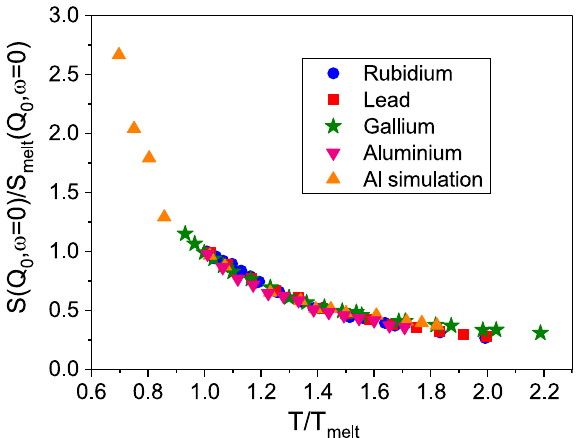
Figure 5. Amplitudes S ( Q , ω = 0 ) , normalized against their melting temperature value, are depicted against a normalized temperature for different liquid metals. Data include rubidium 40 , lead 41 , gallium 42 and the here presented experimental and simulation aluminium